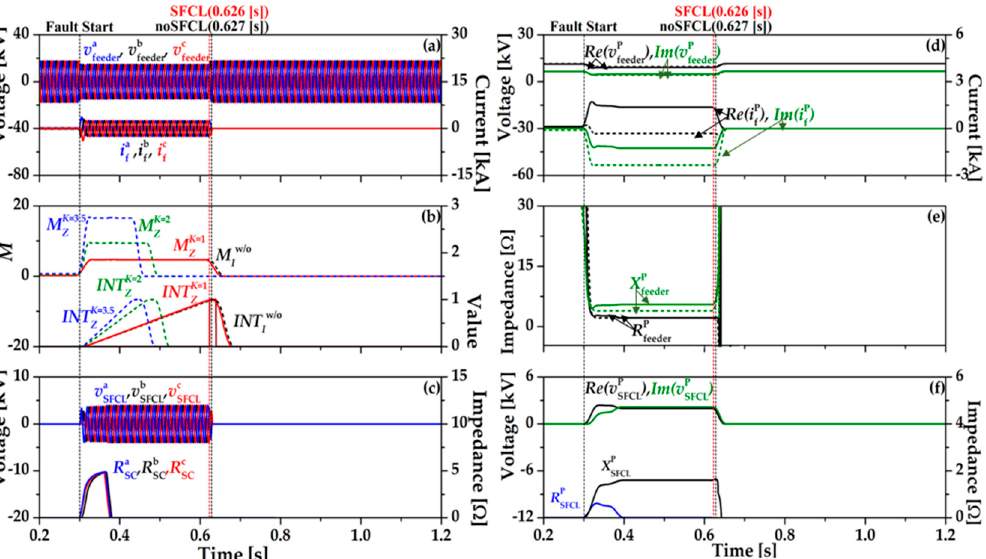
Figure 9. Waveforms and signals of OCR using M I , M Z in TLG. ( a ) Three phase feeder voltage ( v feeder ), current ( i f ). ( b ) Index of CB ( M I , M Z ) and signal of OCR ( INT I , INT Z ). ( c ) Three phase SFCL voltage ( v SFCL ), HTSC element ( R a SC , R b SC, R c SC ). ( d ) Positive sequence feeder voltage ( v P feeder ), positive sequence feeder current ( i P f ). ( e ) Positive sequence feeder impedance ( R P feeder , X P feeder ). ( f ) Positive